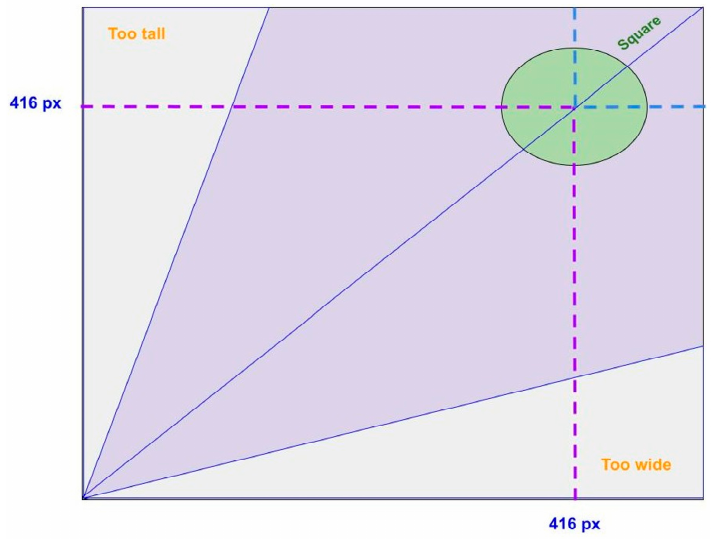
Figure 11. Aspect ratio distribution graph.